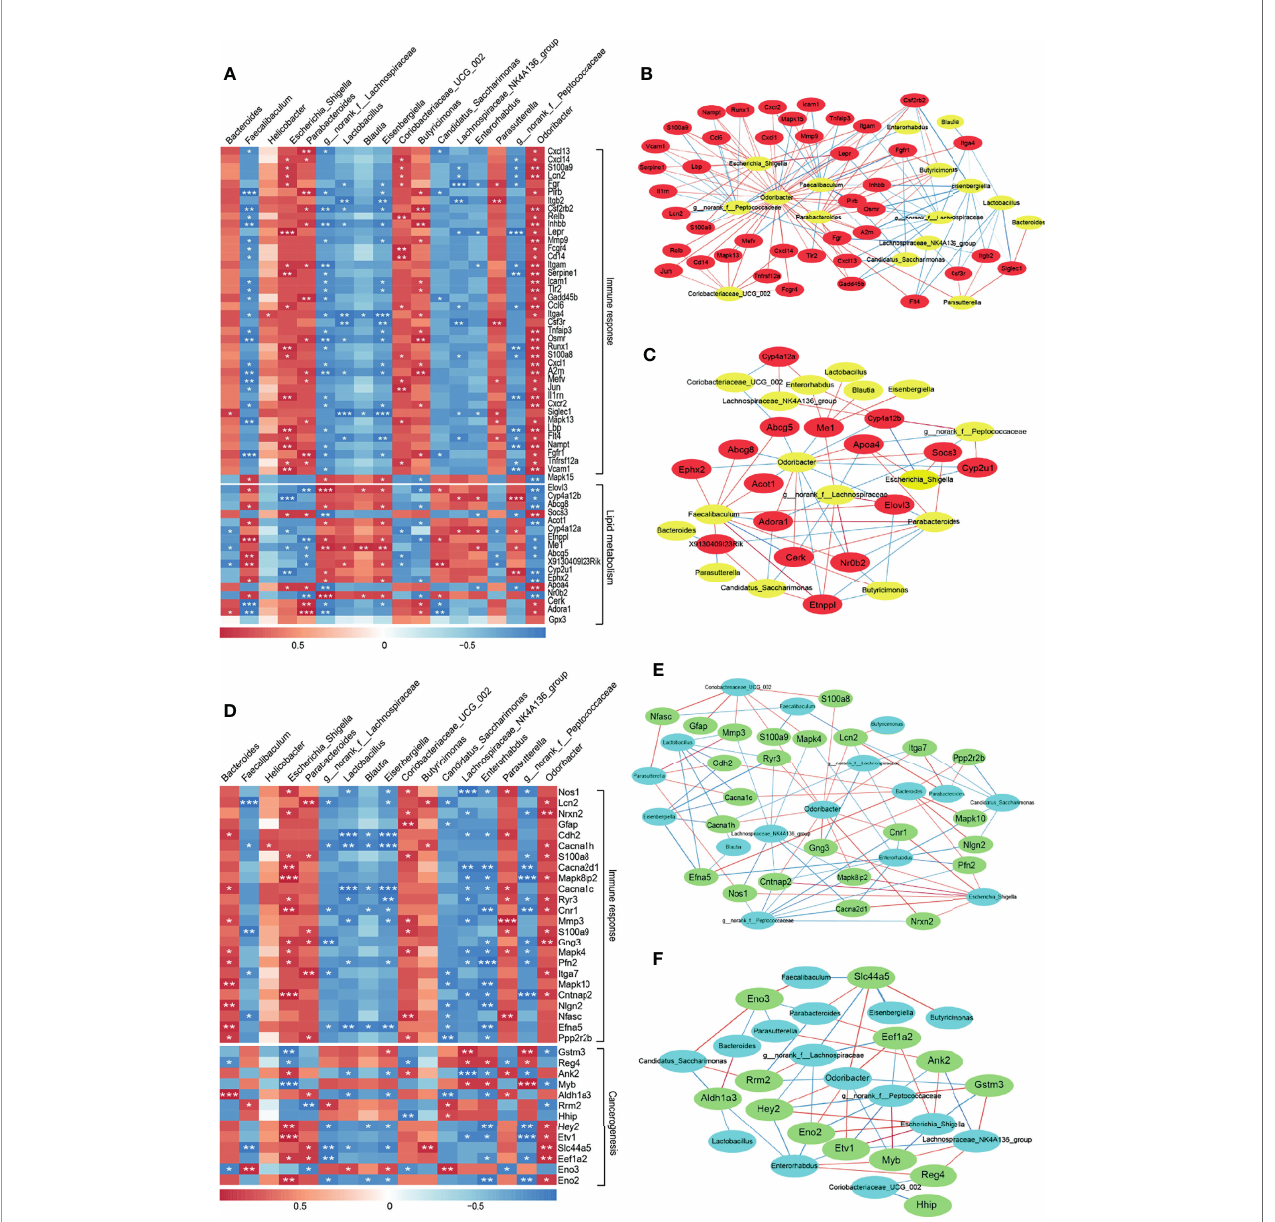
FIGURE 6 | Interaction between gut microbiota and DEGs in the colon and liver in healthy (CON) and acute colitis (DSS). (A, D) Correlation of gut microbiota with genes enriched for immune response and lipid metabolism or cancerogenesis-related functions among the top 250 DEGs in the liver (A) and colon (D) (* P < 0.05, ** P < 0.01, *** P < 0.001). (B, C) Network visualization of signi fi cant gene-microbe correlations in the liver associated with immune response (B) and lipid metabolism (C) ( P < 0.05). (E, F) Network visualization of signi fi cant gene-microbe correlations in the colon associated with immune response (E) and cancerogenesis (F) ( P < 0.05). Blue and red edges represent negative (R < -0.85) and positive (R > 0.85) correlations, respectively, respectively. Edge thickness indicates the strength of the